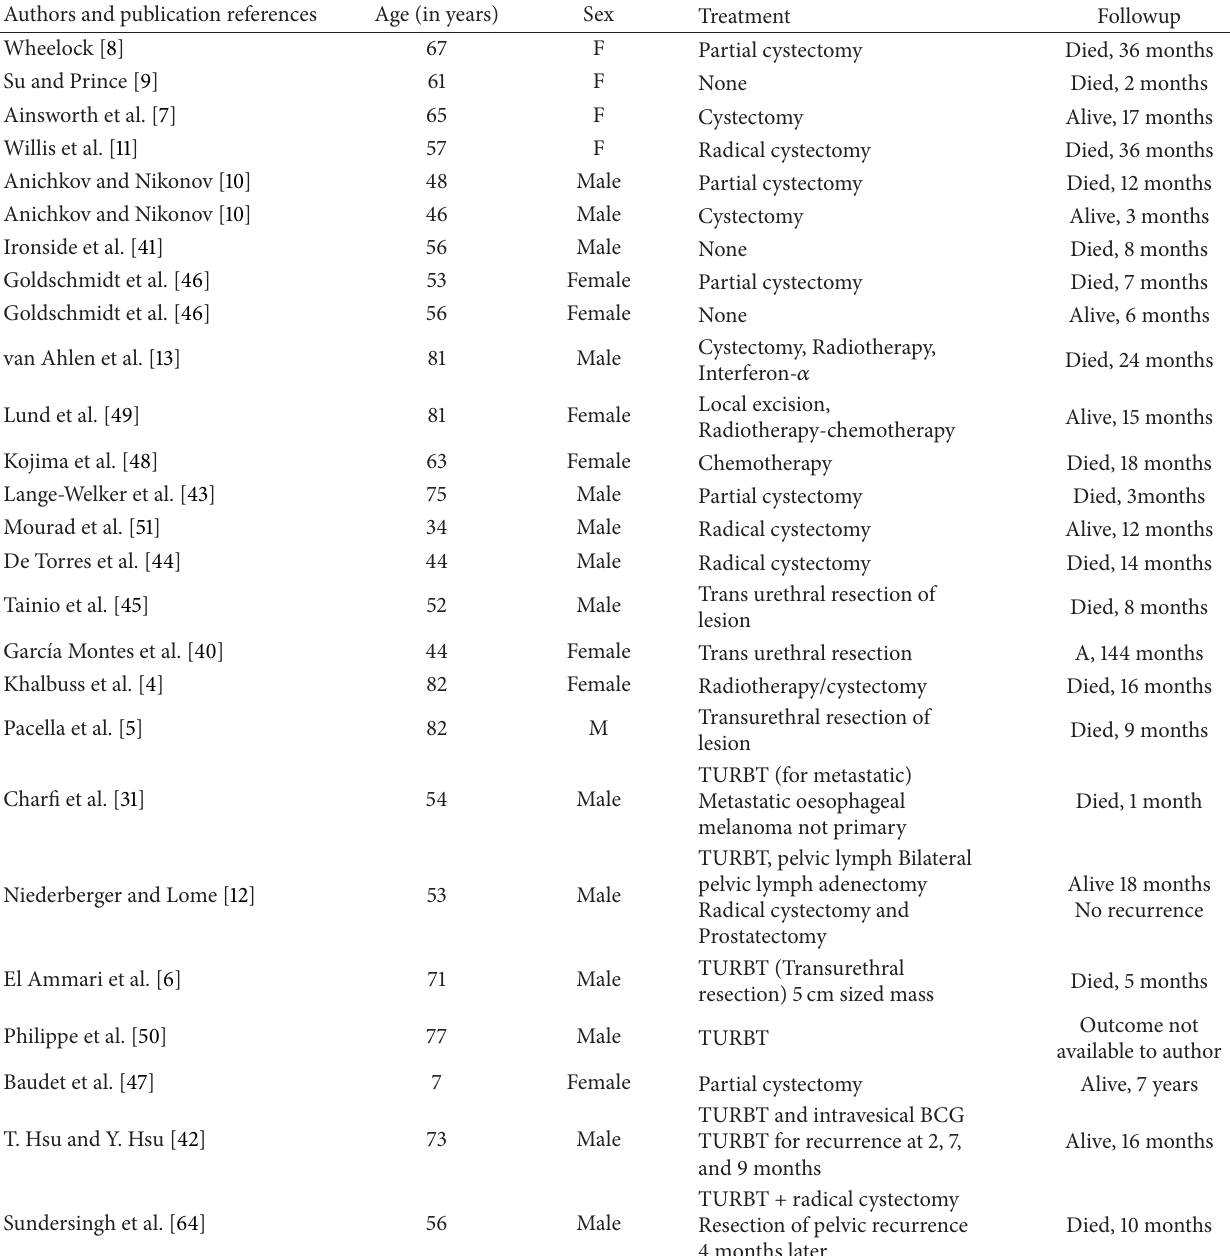
Table 1: List of some of the cases of primary malignant melanoma of bladder reported in the literature with treatment and outcome (this list has 26 primary and one metastatic bladder melanoma; only one metastatic melanoma was included; there are more metastatic bladder melanomas but only 26 primary melanomas of the urinary bladder were found by the